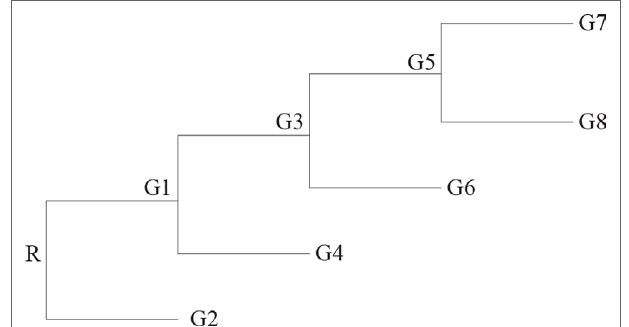
FIGURE 3 | The topology used to generate the simulation